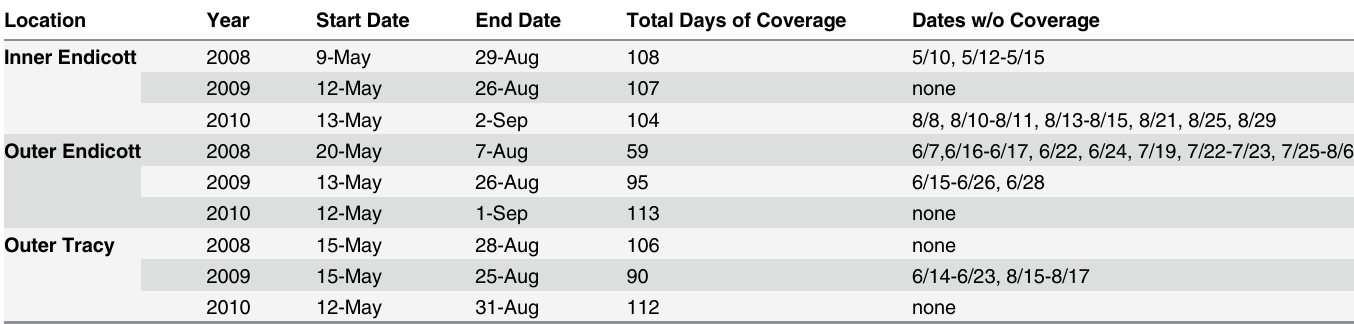
Table 1. Dates and locations of telemetry